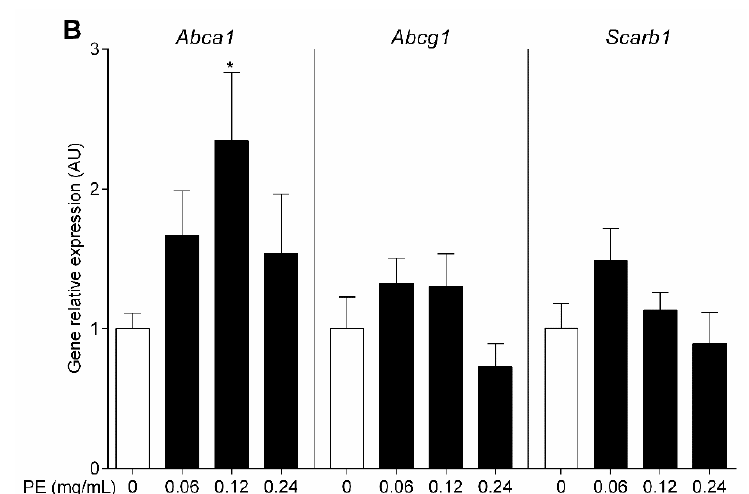
Figure 3. OO phenolic compounds upregulate macrophage Abca1 expression. ( A ) Hydroxytyrosol sulfate levels in the serum after 2, 6, and 24 h post-administration of ROO, FVOO, PE, or the vehicle (saline). Values are the mean ± SEM of 3 individual mice / group. * p < 0.05 vs. saline, † p < 0.05 vs. ROO, and ‡ p < 0.05 vs. PE, analyzed by ANOVA Tuckey’s multiple comparison test. ( B ) Real-time PCR quantification of relative mRNA expression in J774A.1 macrophages treated with PE (0.06, 0.12, and 0.24 mg / mL of PE correspond to 0.5, 1, and 2 µ M of hydroxytyrosol present in the PE, respectively) for 4 h. The signal of control J774A.1 macrophages without the PE was set to a normalized value of 1 AU for each gene. Three independent experiments were performed for each condition. * p < 0.05 vs. 0 mg / mL PE.